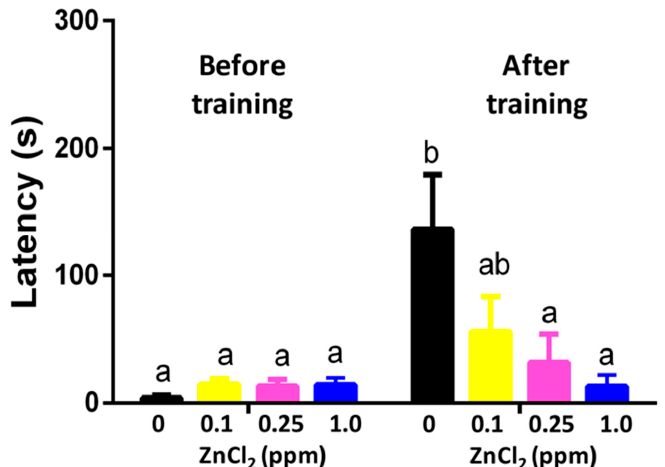
Figure 4. Passive avoidance on training and memorial test after 96 h of exposure to ZnCl 2 after nine-day exposure. Data are presented as means ± standard error of the mean (SEM) ( n = 12) and analyzed individually for each treated group. Statistics analysis was performed by one-way ANOVA, followed by Tukey as the post hoc test. Different labels above columns indicate a significant difference with p < 0.01 (a, p ≤ 0.05; ab, p ≤ 0.01; b, p ≤